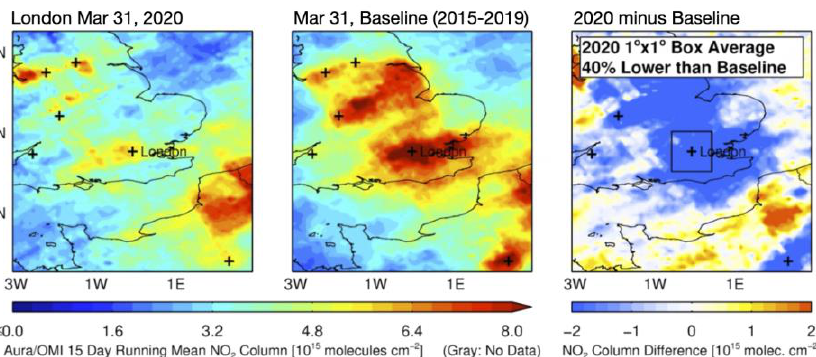
Figure 15. Nitrogen dioxide concentrations over London on 31 March of 2020 and on 31 March in the period of baseline (2015–2019). Source: NASA AURA [23].